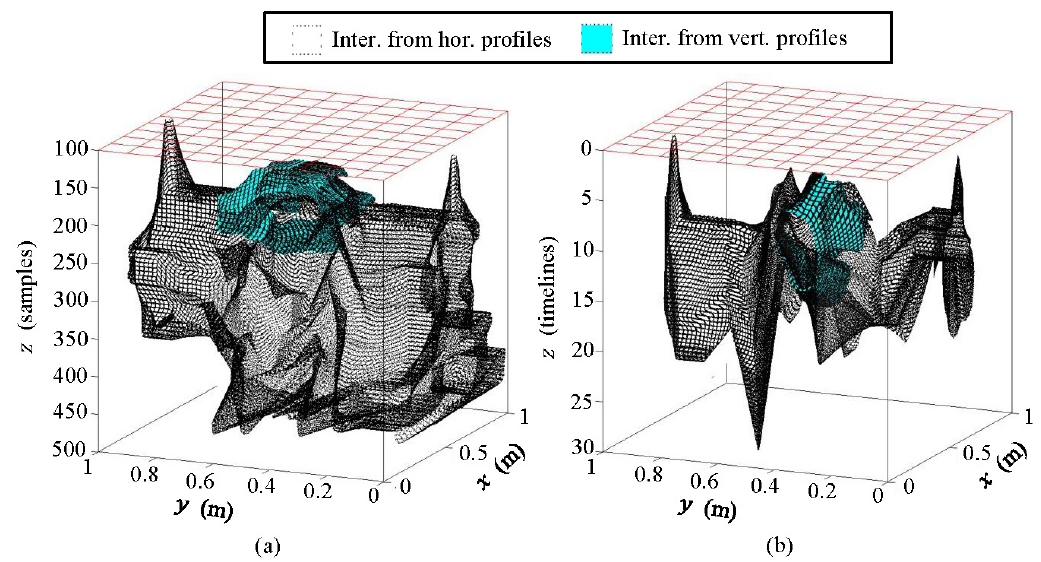
Comparison between 3D models generated from the interpretation of the horizontal and the vertical profiles contrasting the initial and the final states: ( a ) 3D model obtained from raw images; ( b ) 3D model obtained from pre-processed